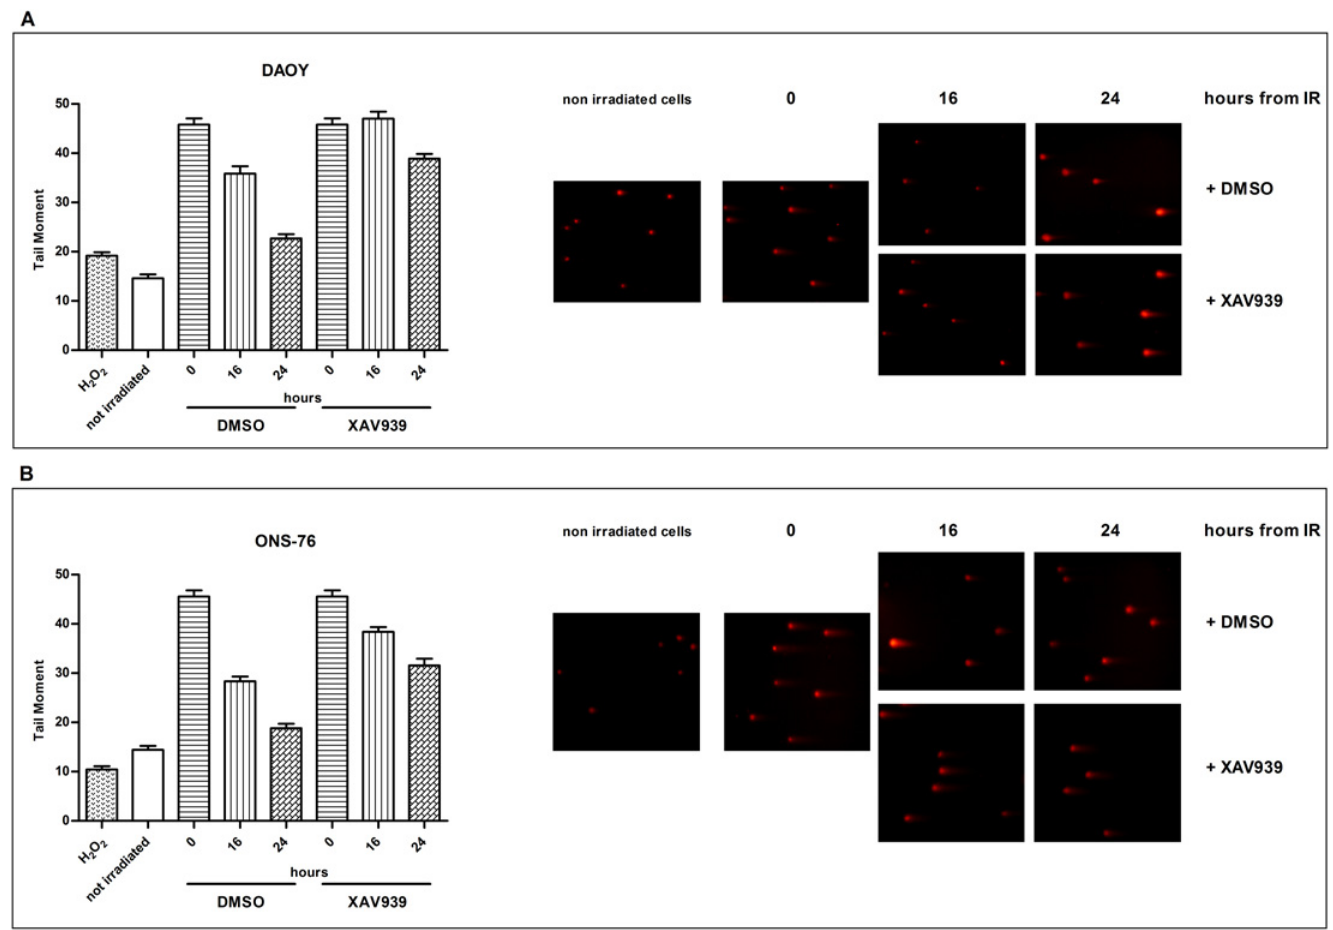
Fig 3. XAV939 affects the DNA repair efficacy of MB cell lines. Neutral Comet Assay was performed on IR treated cells (10 Gy), with or without XAV939 administration, at different time points post radiations (0, 16, and 24 h). Histograms represent mean ± s.e. of TM measured in at least three independent experiments for each treatment and time point. The greatest TM was observed immediately after IR treatment in both cell lines (A: DAOY, B: ONS-76). XAV939 induces enhanced TM values at 16 h and 24 h after IR compared to DMSO irradiated cells indicating a minor DNA repair capacity. On the right of the figure, a representative example of comets for each treatment obtained in DAOY (upper) and ONS-76 (down) cells.